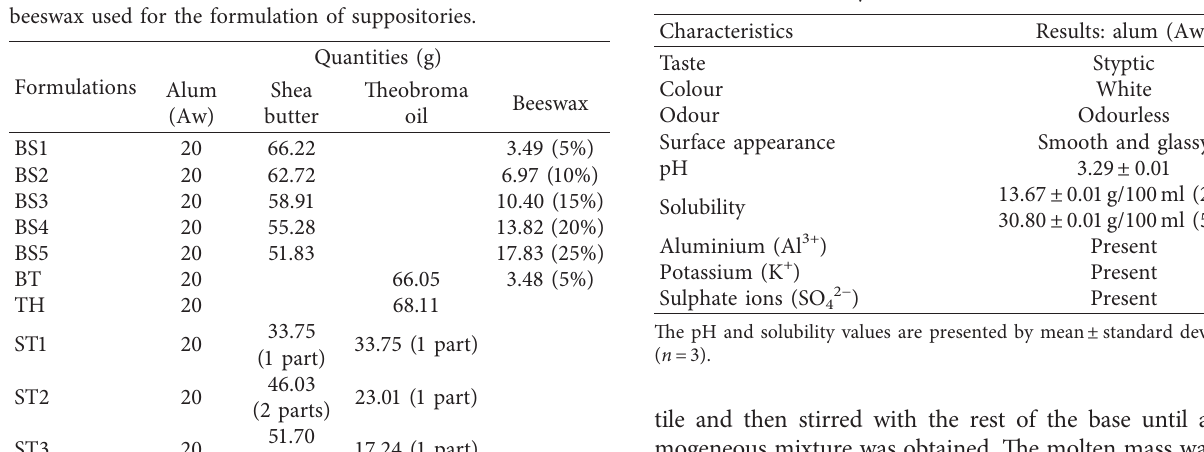
Table 2: Physical characteristics of the